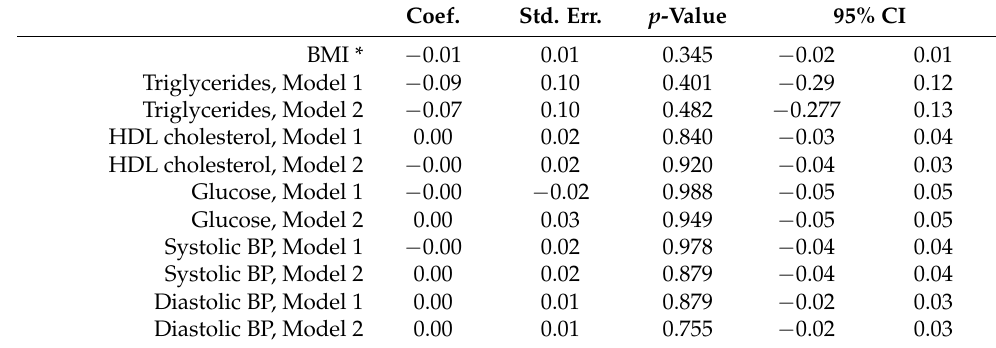
Table A2. Adjusted associations between self-reported AT (min/day) and CVD risk factors, with and without adjustment for